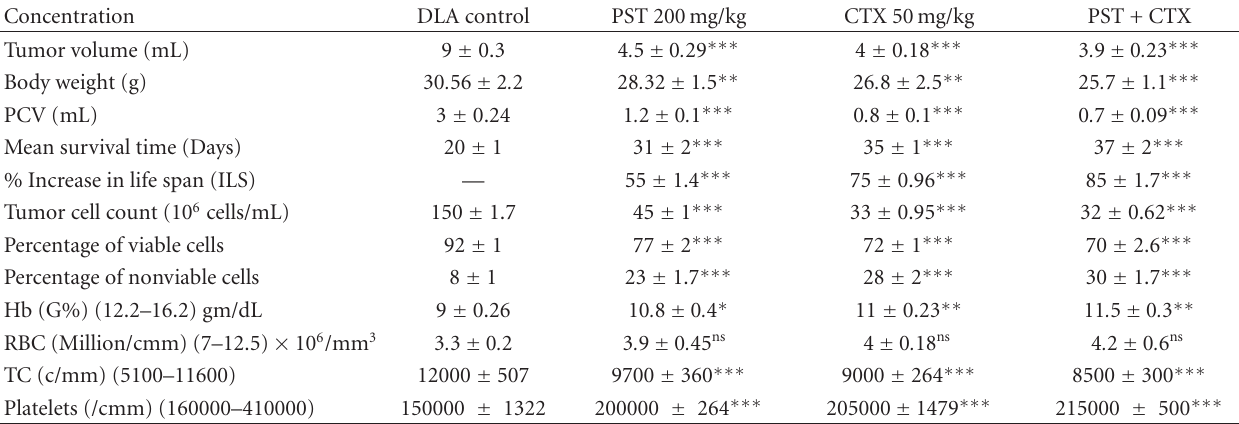
Table 2: Tumor and hematological characteristics in mice injected with DLA on day 1 followed by PST001/drug administration for 14 days and dissected on 15th day (Group 2).